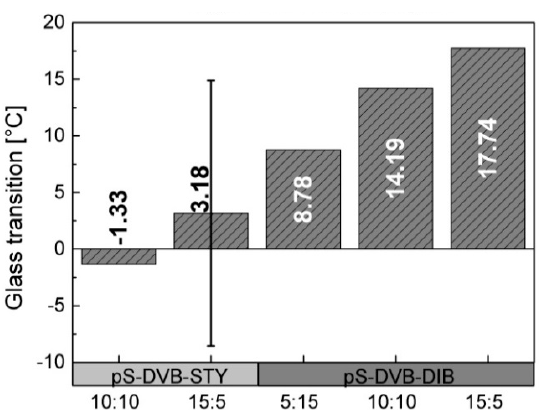
Figure 8. Glass transition of terpolymer based on pS-DVB with STY and DIB. The monomer content amounts to 20 wt %.